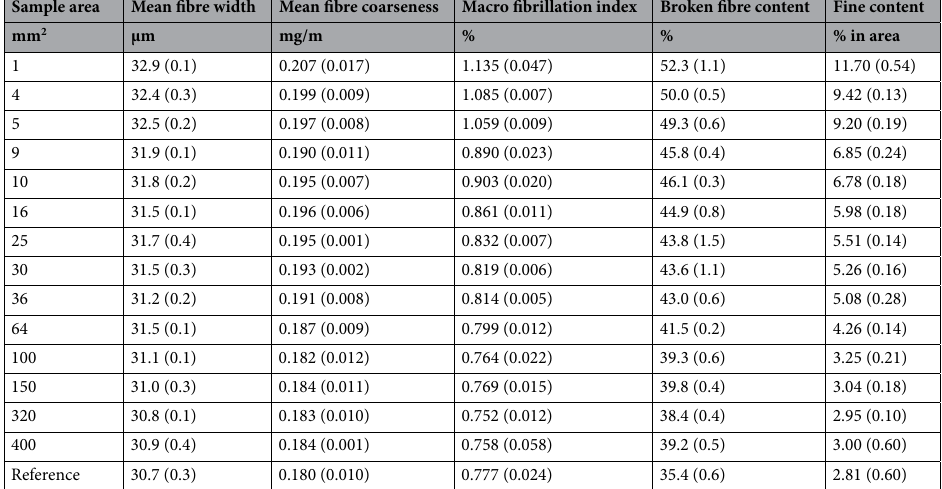
Table 3. Fibre and pulp properties after model pulp recycling process including refining. Standard deviation are given in brackets.